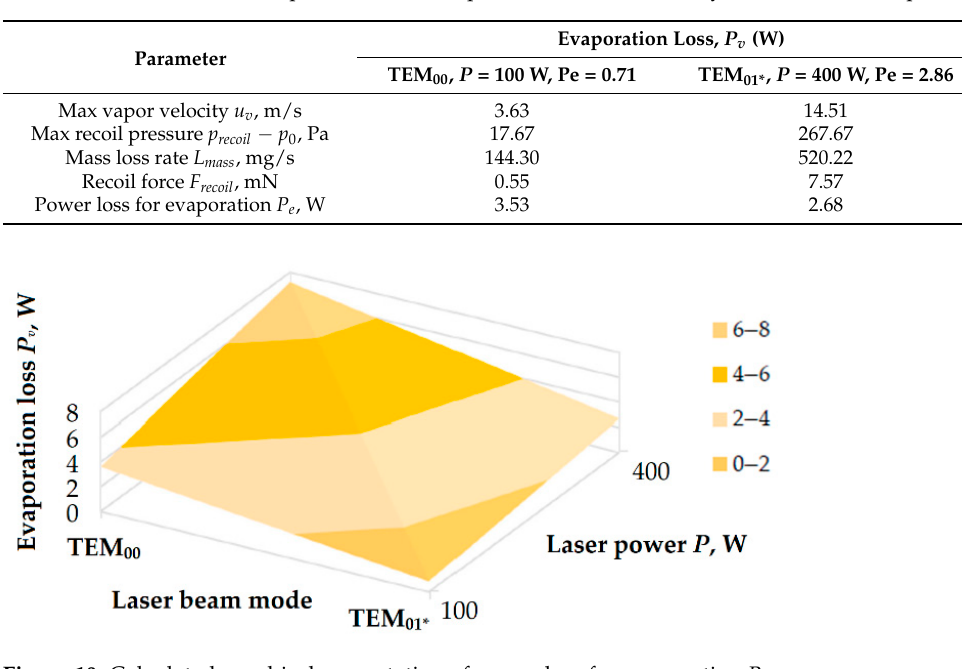
Figure 10. Calculated graphical presentation of power loss for evaporation Pv .